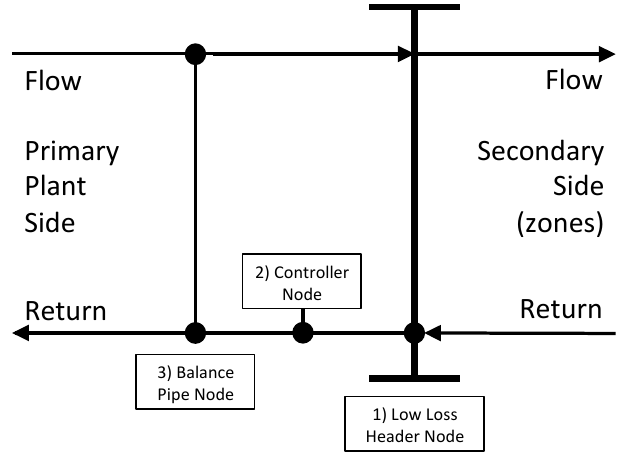
Figure 1. Modelling of primary HVAC Figure 1 : Modelling of Primary HVAC Systems